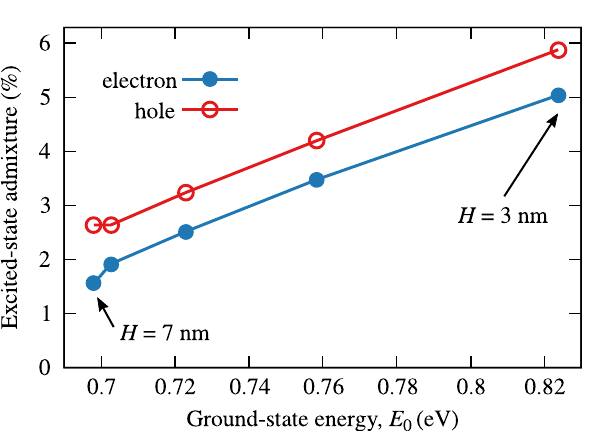
Figure 10. Energy dependence of electron-hole correlation. Amount of electron (full symbols) and hole (empty) excited-state admixtures to the exciton ground state plotted as a funcion of ground-state energy for InAs/AlGaInAs QDs with varying height. Lines are to guide the